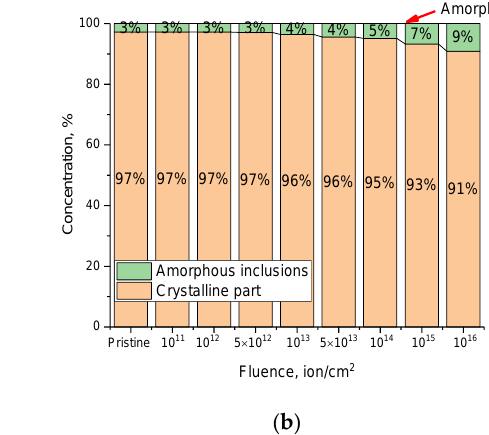
Figure 4. ( a ) X-ray diffraction patterns of the studied samples of ZrO 2 ceramics depending on the irradiation fluence; ( b ) Dynamics of changes in diffraction reflections in the region of 2θ = 29– 31°; ( c ) Dynamics of changes in diffraction reflections in the region of 2θ = 34– 36°. The second stage of changes is typical for fluences of 10 13 – 10 14 ion/cm 2 , which is characterized not only by a shift of diffraction reflections, indicating the deformation nature of structural changes, but also by a change in the ratio of the intensities of diffrac- tion reflections for t-ZrO 2 and c-ZrO 2 , which indicates processes of polymorphic trans-